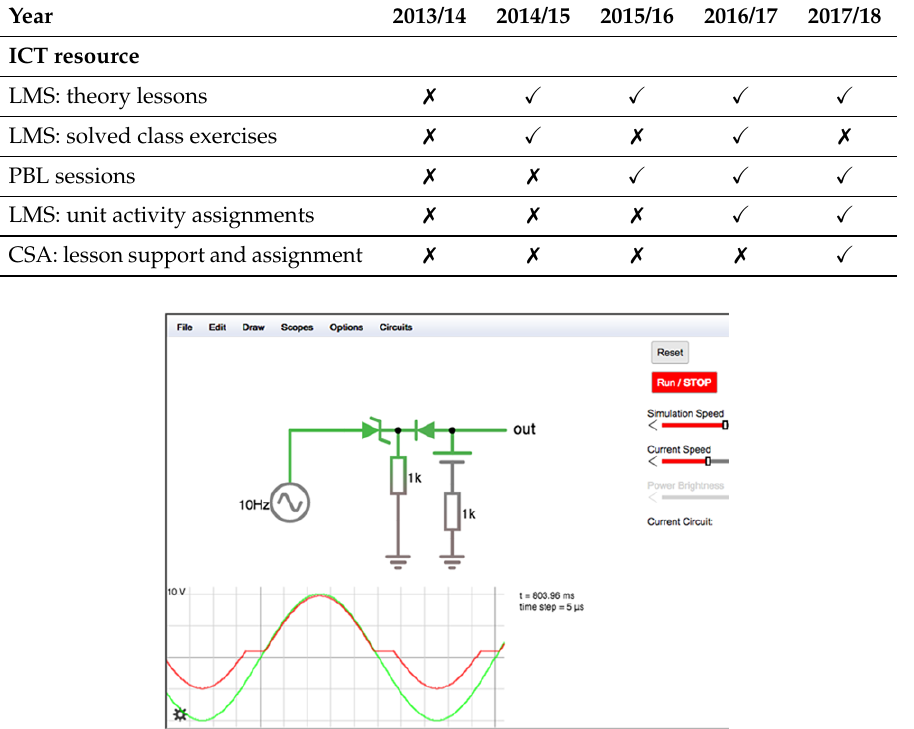
Figure 2. Java interface of the CSA (Circuit Simulation Applet). Example of activity considered in the revision dossier to be handed